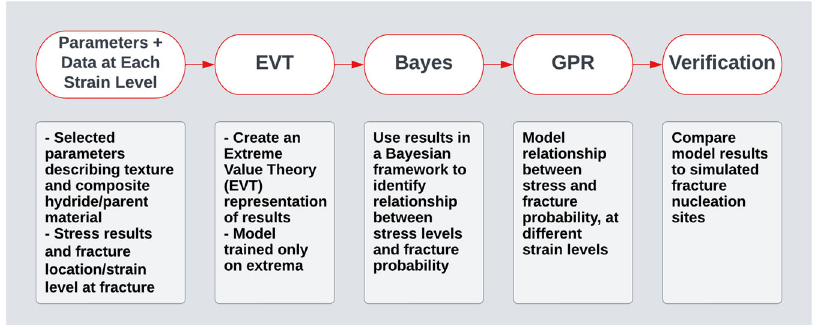
Fig. 1 An outline of the ML fracture failure probability